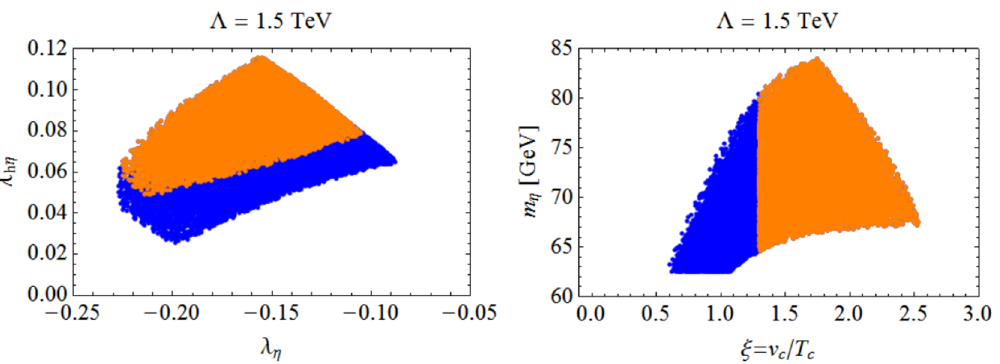
Figure 2 . Values of the parameters for which a one-step (S)FOEWPhT occurs. The orange points correspond to the SFOEWPhT condition, ξ ≥ 1 . 3 . The cutoff of the dimension-6 operator has been set to Λ = 1 . 5